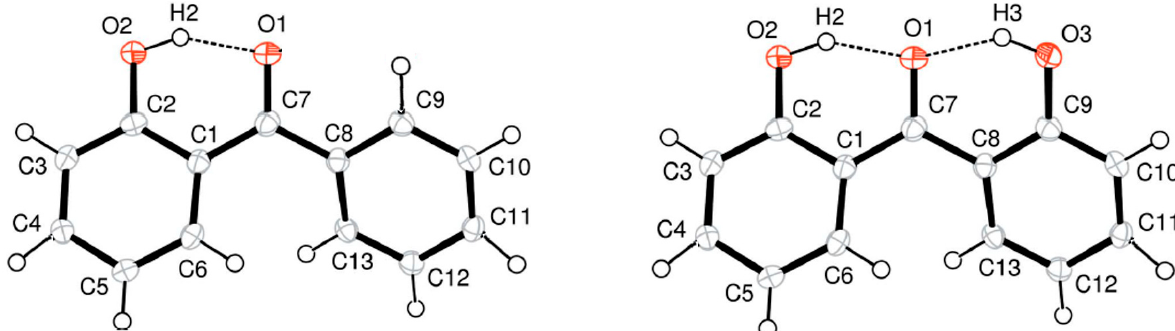
Figure 9. Intra-molecular hydrogen bonding in 2-hydroxy-benzophenone ( left ) and 2,2’-di-hydroxy- Figure 9. Intra ‐ molecular hydrogen bonding in 2 ‐ hydroxy ‐ benzophenone ( left ) and 2,2’ ‐ di ‐ hy ‐ benzophenone ( right droxy ‐ benzophenone ( right ).